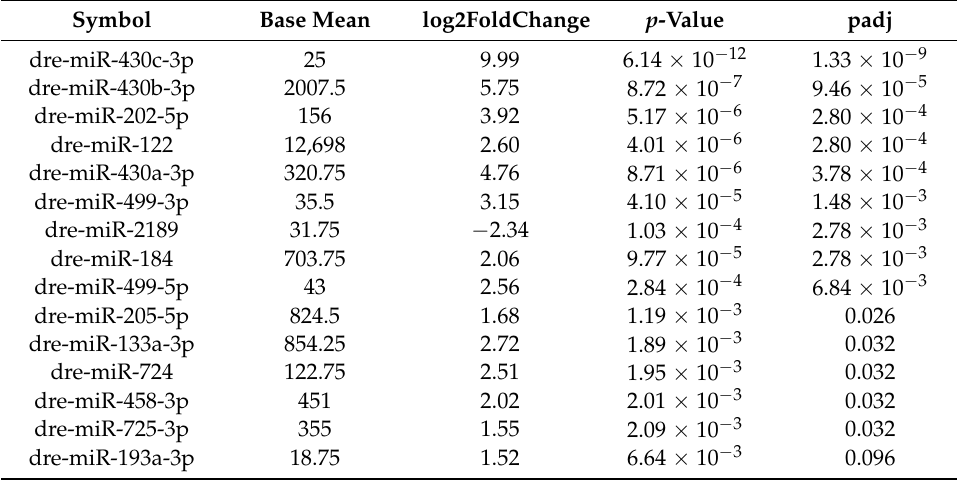
Table 1. Significant deregulated miRNAs obtained from EdgeR analysis ( q ≤ 0.1). All miRNAs listed here were upregulated in the liver after bisphenol A (BPA) exposure except miR-2189, the only miRNA that was downregulated (see log2FoldChange column). The Base Mean is a mean value for the counts obtained from the various